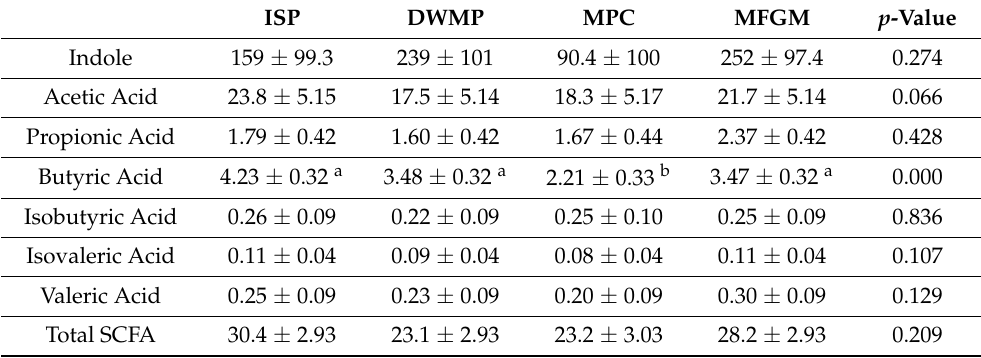
Table 6. Cecal metabolite content.